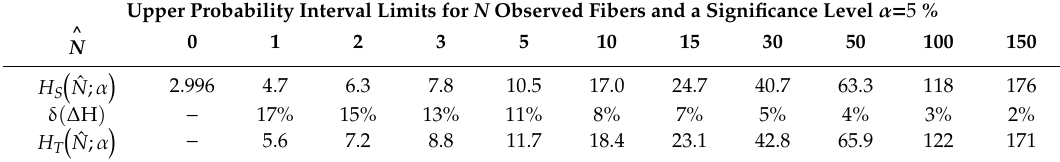
Table 9. Upper limits of the probability intervals H S ( ˆ N ) and H T ( ˆ N ; α ) = H S ( ˆ N ; α / 2) as derived from the single (Section 2.7.2) and the two-hypotheses (Appendix B) tests for ˆ N observed fibers and a per-tail significance levels of α = 5% and α / 2 = 2.5%, respectively. The single-test upper limit H S is by a fraction of δ ( ∆ H ) = ( H T − H S ) / H S smaller than the upper limit H T from twin testing. ^ N Observed Fibers and a Significance Level α = 5 % Upper Probability Interval Limits for